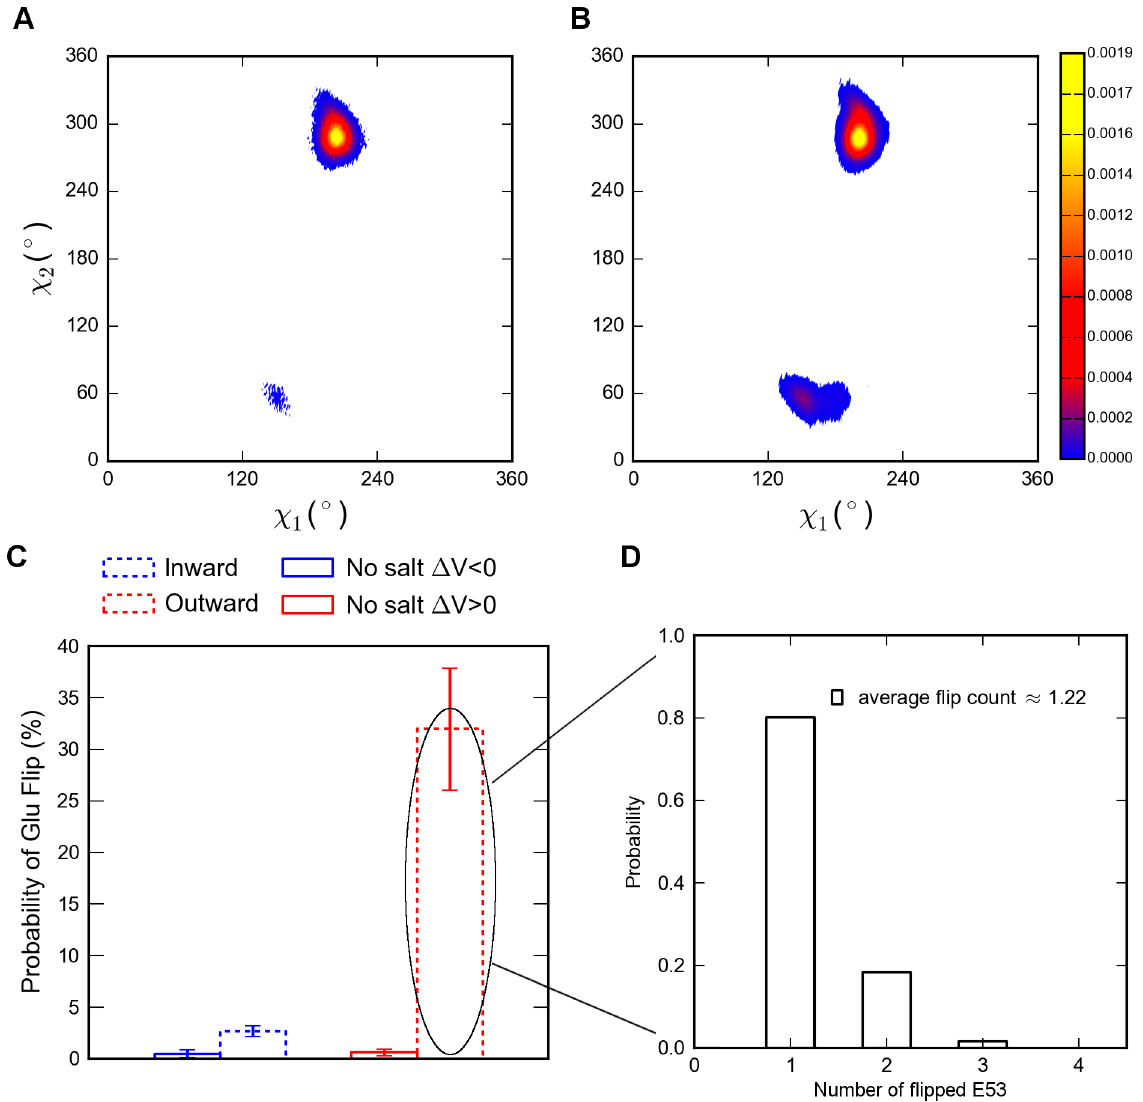
Figure 5. E53 conformational changes. A) x 1 - x 2 angle distribution of the inward conductance simulations. B) x 1 - x 2 angle distribution of the outward conductance simulations. C) The probability of flipping events of E53 side chains, the inward conduction is depicted as blue dotted histogram. The outward conduction is depicted as red dotted histogram (a flip is defined when at least one out of four subunits was shifted to flipping state in an analyzing window over time from four simulations); Control simulations with ions not in the SF (‘‘no salt’’) at hyperpolarized and depolarized membrane potentials are depicted as blue and red solid histograms, respectively. Error estimations shown in the figure are S.E.M. D) The distribution of E53 flipping numbers from all flipping events during outward